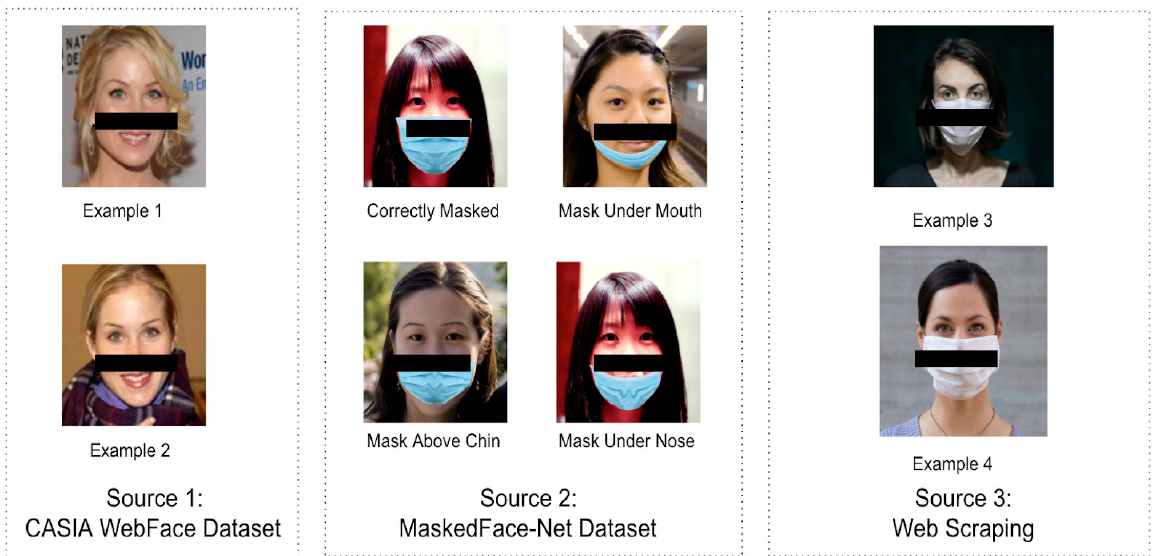
Figure 1. Sample Image Data from Multiple Sources.